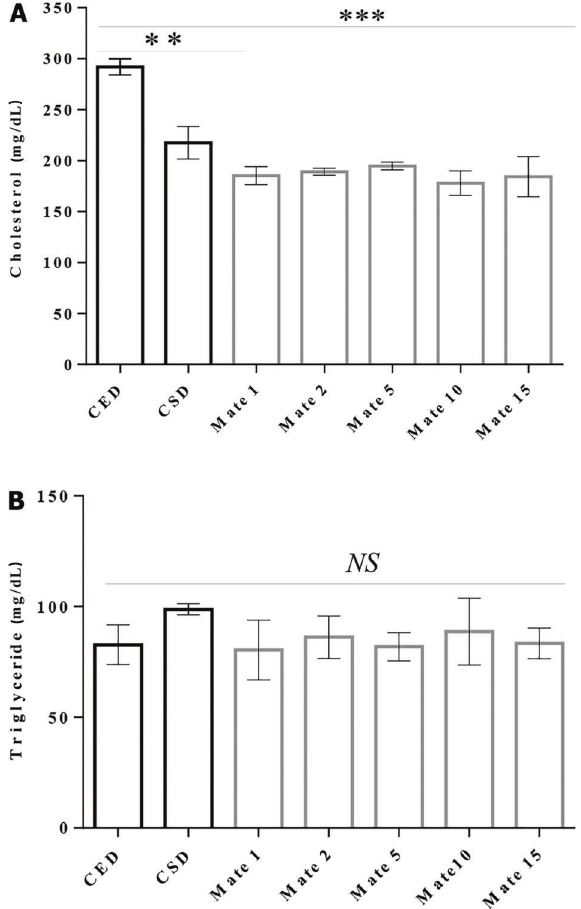
Figure 6. Cholesterol ( A ) and triglyceride ( B ) levels (per mg live weight) in the whole-body homogenate of fl ies after 10 days on various diets: standard (CSD), experimental (CED) and experi- mental diet + mates (Mate 1 to Mate 15). Flies were homogenized in groups of 20 males. Data are reported as means ± SE. NS: not signi fi cant. **P o 0.01, ***P o 0.001, one-way ANOVA followed by Dunnett ’ s multiple comparisons test.